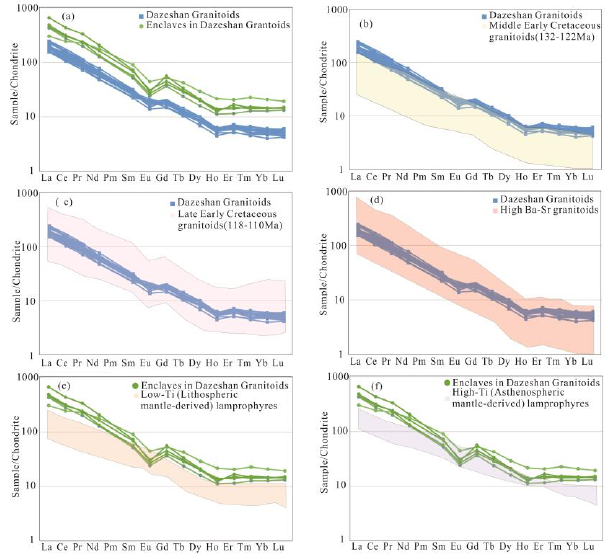
Figure 6. Comparison of chondrite-normalized REE patterns between granitoids of the Dazeshan and their enclaves ( a ), Dazeshan granitoids and middle Early Cretaceous granitoids (132 – 122 Ma) ( b ), Dazeshan granitoids and late Early Cretaceous granitoids (118 – 110 Ma) ( c ), Dazeshan granitoids and high Ba–Sr granitoids ( d ), Dark microgranular enclaves and low-Ti (Lithospheric mantle-derived) lamprophyres ( e ), and Dark microgranular enclaves and high-Ti (Asthenospheric mantle-derived) lamprophyres ( f ). The published data for middle Early Cretaceous granitoids (132–122 Ma) are from [64–66], for Late Early Cretaceous granitoids (118–110 Ma) from [49,50,67], for high Ba–Sr granitoids from [24], and for low-Ti and high-Ti lamprophyres from [47].